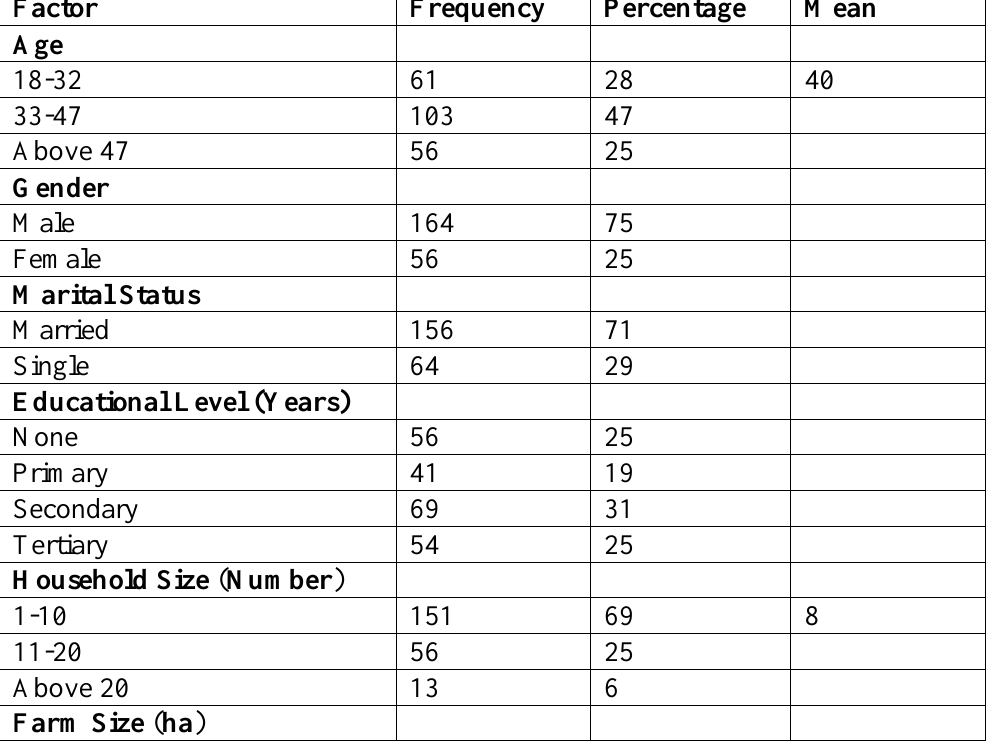
Table 2. Distribution of the respondent according to their socio-economic attributes